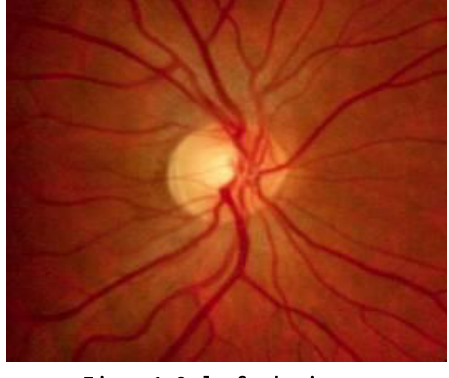
Figure 1. Color fundus